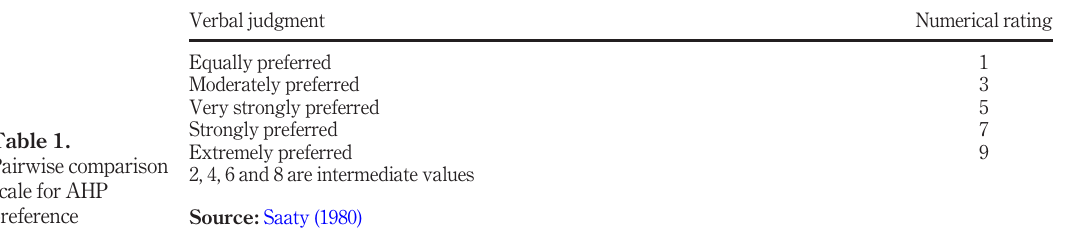
Figure 2. Illustrating the methodological stepsSource: Own